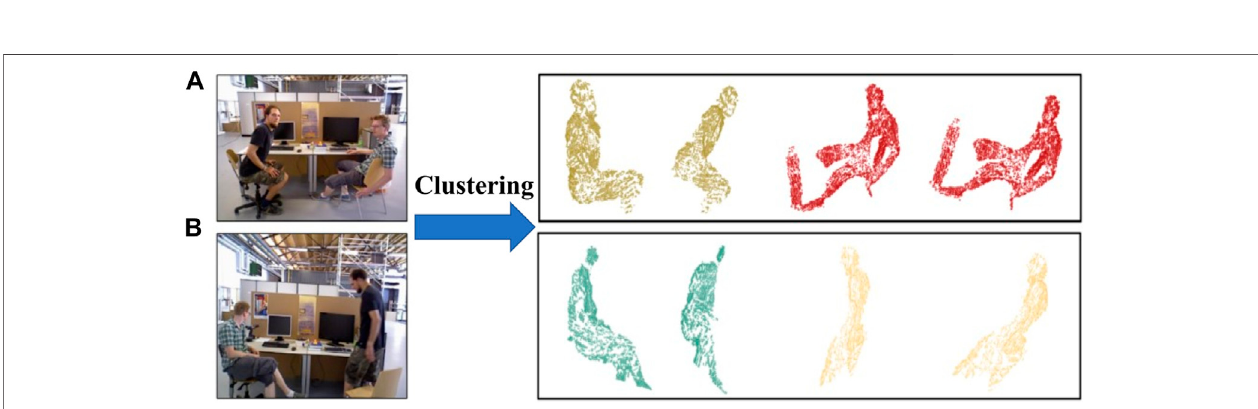
FIGURE7 | ExamplesofEuclideansegmentation in TUM dataset, (A) isthe point cloud segmentation withhumanbodies inthe sitting posture, (B) are theclusters of the human body in the sitting and standing posture.